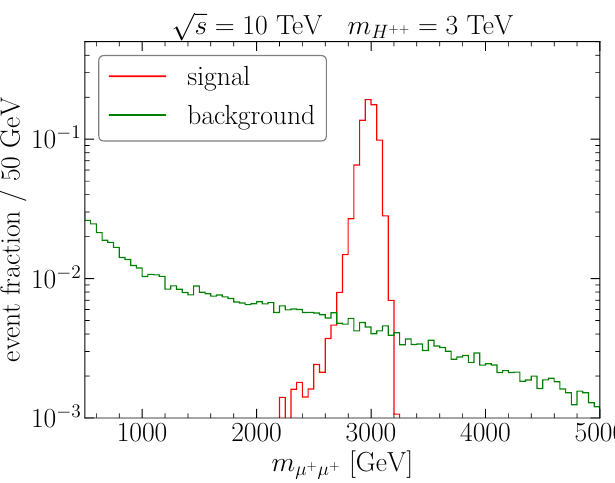
Figure 10 . The invariant mass of the same-sign muons µ ± µ ± in H ++ H −− pair production for √ = 3 TeV. The signal and SM background are both shown for comparison. s = 10 TeV and m H ±± The contributions of µ + µ + annihilation and VBF processes are weighted and summed over. The individual backgrounds are also summed